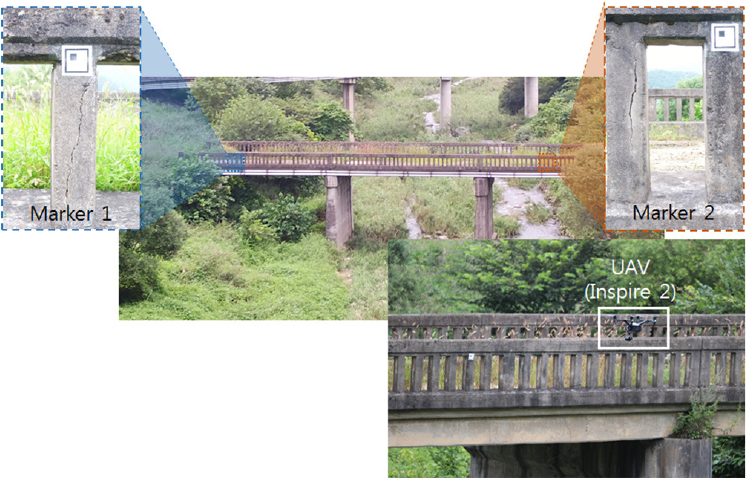
Figure 6. Experimental